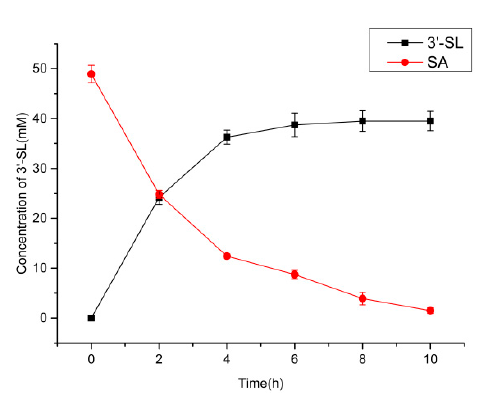
Figure 9. Time course of 3 ′ -SL production under optimal conditions.